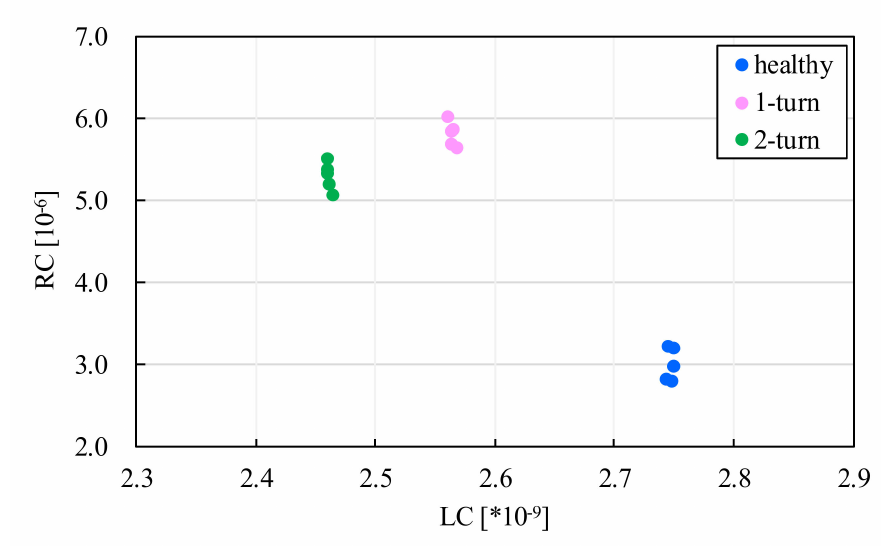
Figure 9. Feature distribution for the 1.5-kW motor 1.